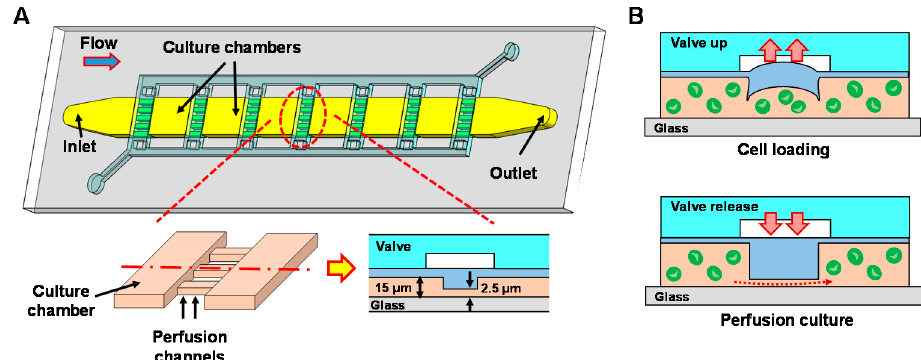
Figure 1. ( A ) A schematic illustration of the polydimethylsiloxane (PDMS) bioreactor. Insets: Close-up and cross-sectional view showing two culture chambers connected via shallow perfusion microchannels. ( B ) Operating principle of the valves showing cell loading process (top) and culture medium perfusion process (bottom).